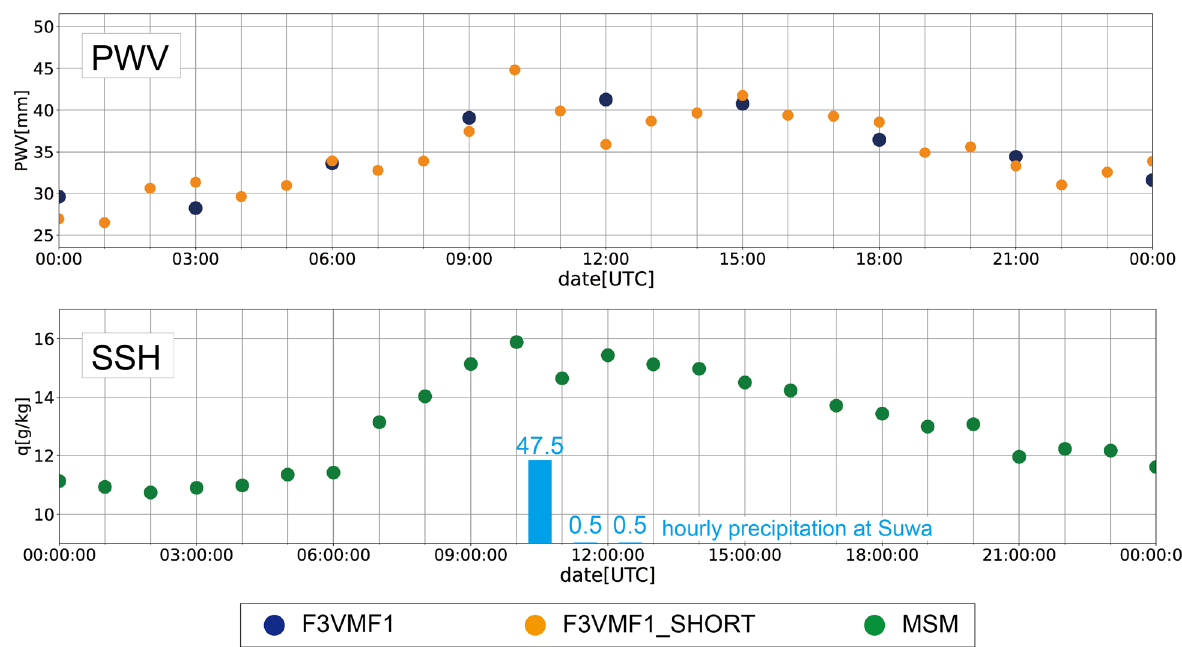
Fig. 11 Changes in PWV and SSH at Shiojiri. The hourly precipitation observed at the nearest AMeDAS station, “Suwa,” is also drawn